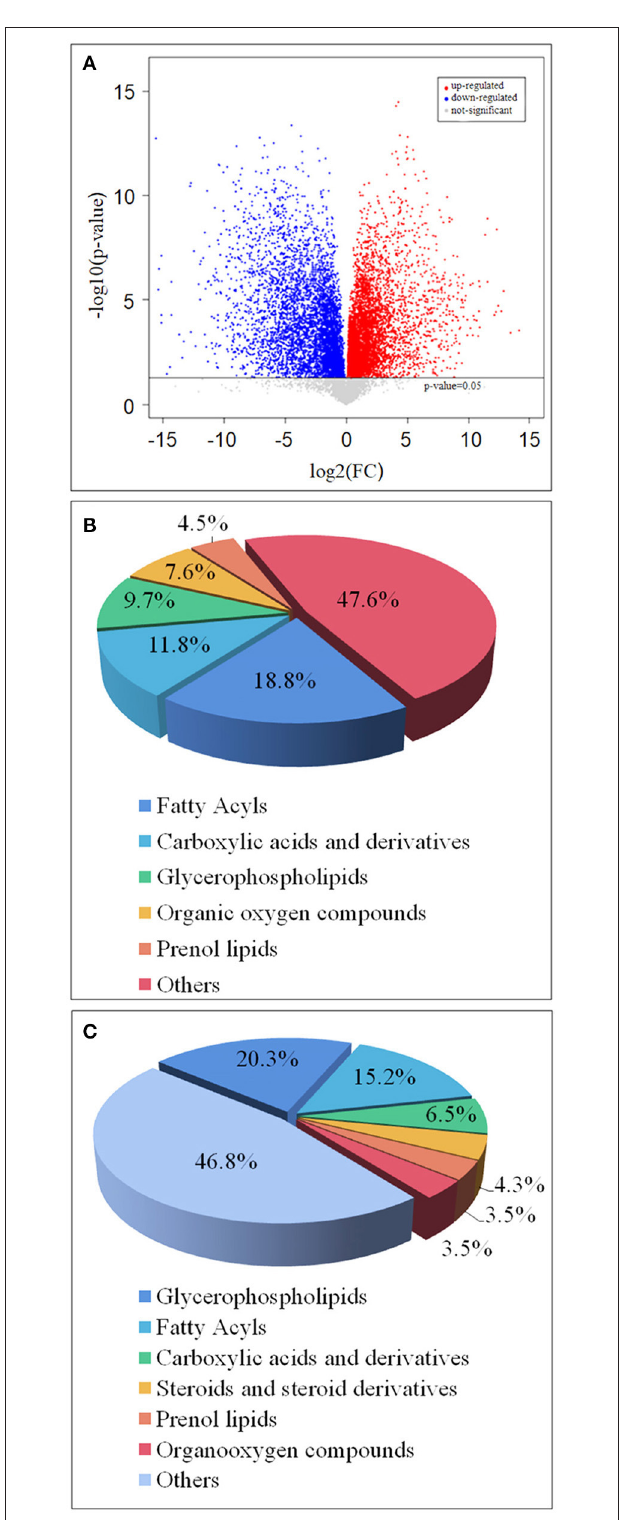
FIGURE 4 | Volcano map of differential metabolites in LS and CK groups (A) , the red origin represents the differential metabolites that are significantly up-regulated, the blue origin represents the differential metabolites that are